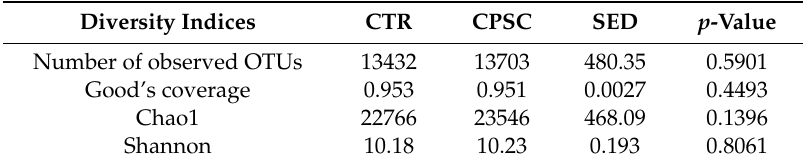
Table 5. Rumen bacterial community diversity analysis when cows were fed a concentrate with cold-pressed sunflower cake or a control